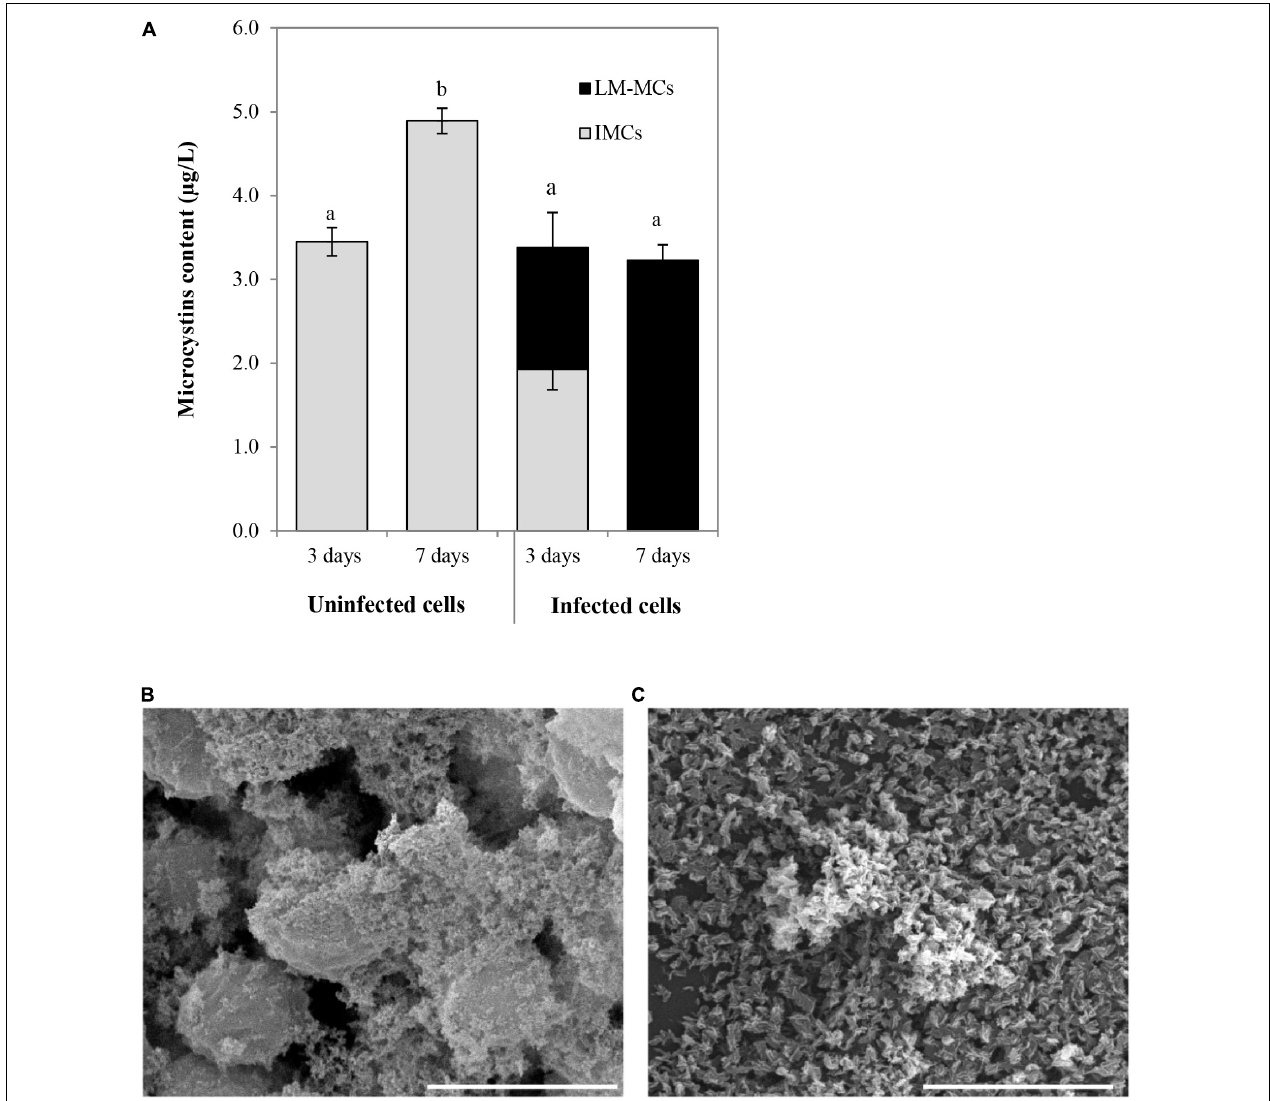
FIGURE 7 | (A) Changes in accumulated microcystins (IMCs) and lysis-mediated microcystins (LM-MCs) after PhiMa05 infecting aggregated Microcystis SG03 at MOI of 100 on days 3 and 7. Each data point is the mean value from three independent experiments ± standard deviation ( P value < 0.05). (B,C) Scanning electron micrographs after the phage treatment at MOI of 100: (B) Uninfected bacterial aggregation, (C) PhiMa05 infecting aggregated cells. Scale bar = 5 µ